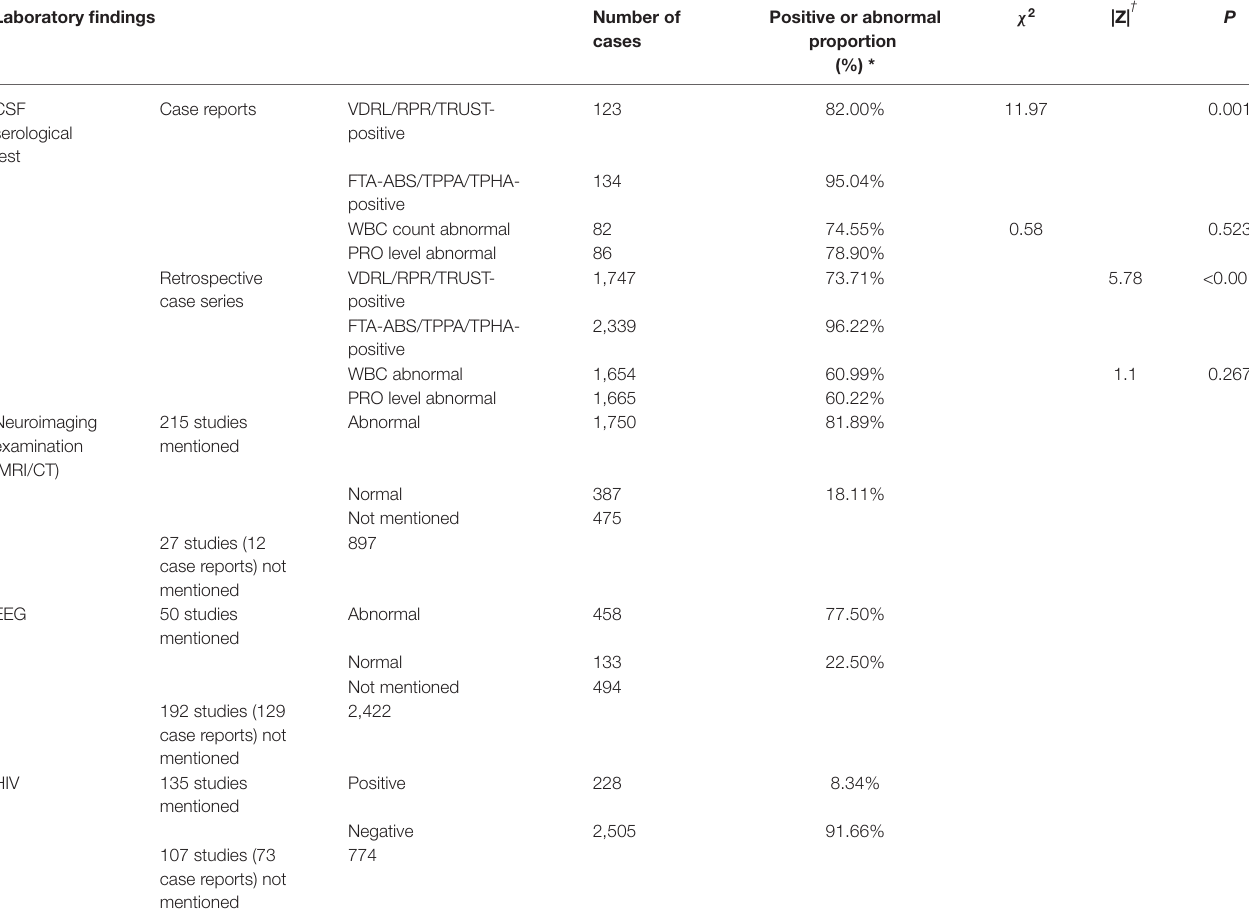
TABLE 2 | Laboratory findings of neurosyphilis cases from 149 case reports and 93 retrospective case